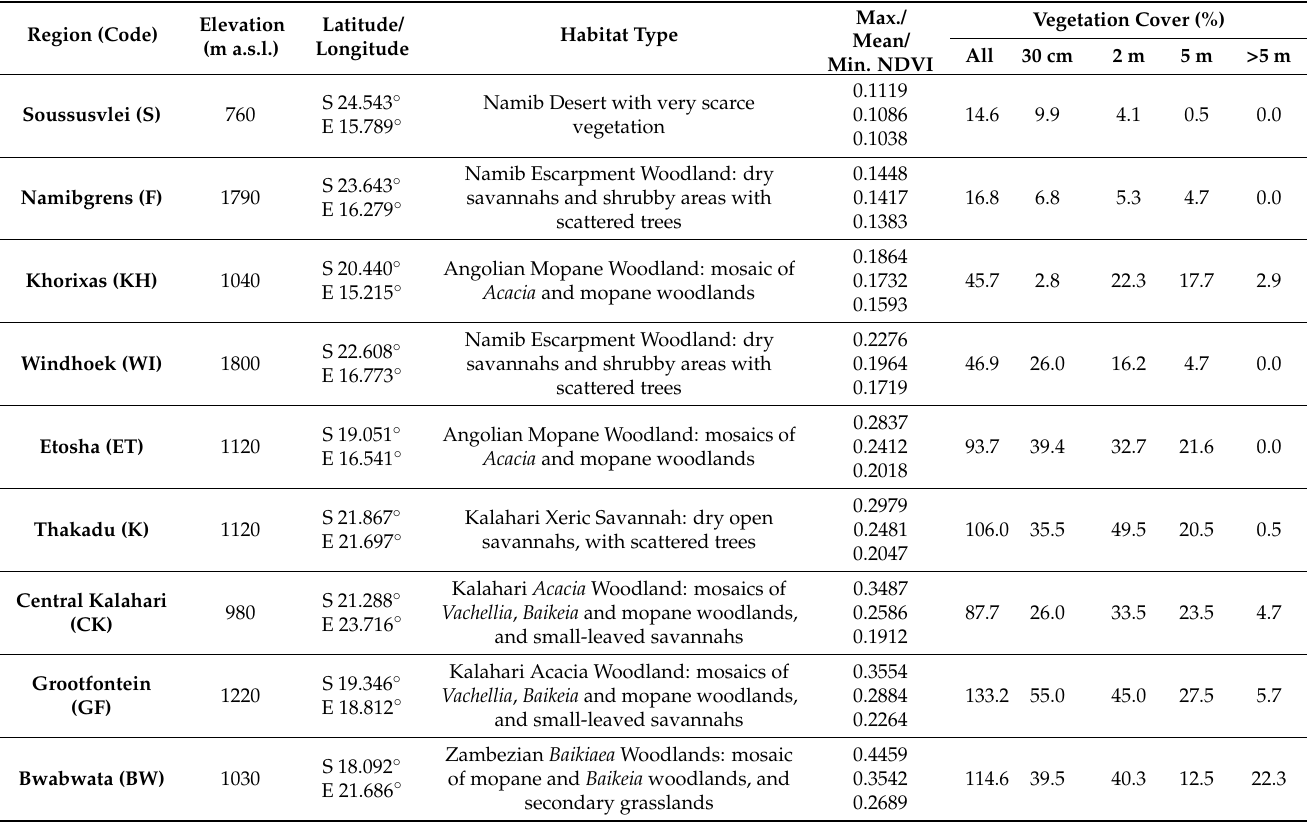
Figure 1. Regions in southern Africa sampled for moth communities along the gradient of environ- mental productivity. Mean NDVI in the beginning of vegetation season (October to December) is visualized. Region codes are listed in Table 1. Table 1. Summary and characteristics of the regions (with their codes used in Figure 1) sampled for moth diversity along the environmental productivity gradient in southern Africa. The NDVI values and vegetation layer coverages were averaged from the 10 plots for each region.